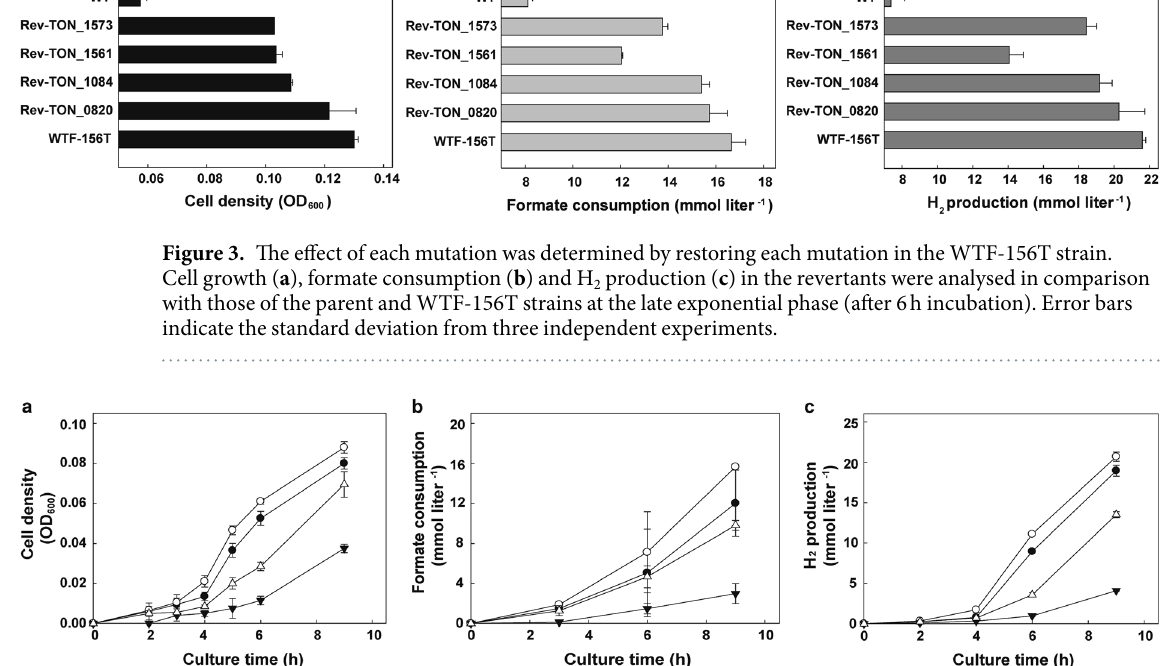
Figure 4. The effect of mutation at TON_1573 or TON_1561. Changes of cell density (optical density at 600 nm) ( a ), formate consumption ( b ) and H 2 production ( c ) were determined in the parent (closed circle), TON_1573 (A52T) (open circle), TON_1561 (G510 insertion) (open triangle) and TON_1573 deleted (closed inverted triangle) strains during the batch culture. Error bars indicate the standard deviations of independent duplicate experiments.